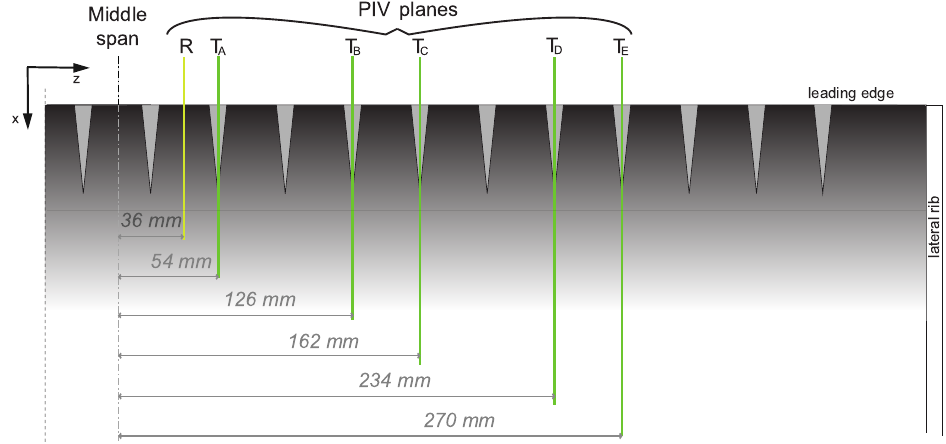
Figure 7. Sketch of the exposed electrode geometry with PIV measurement planes, seen from below in Figure